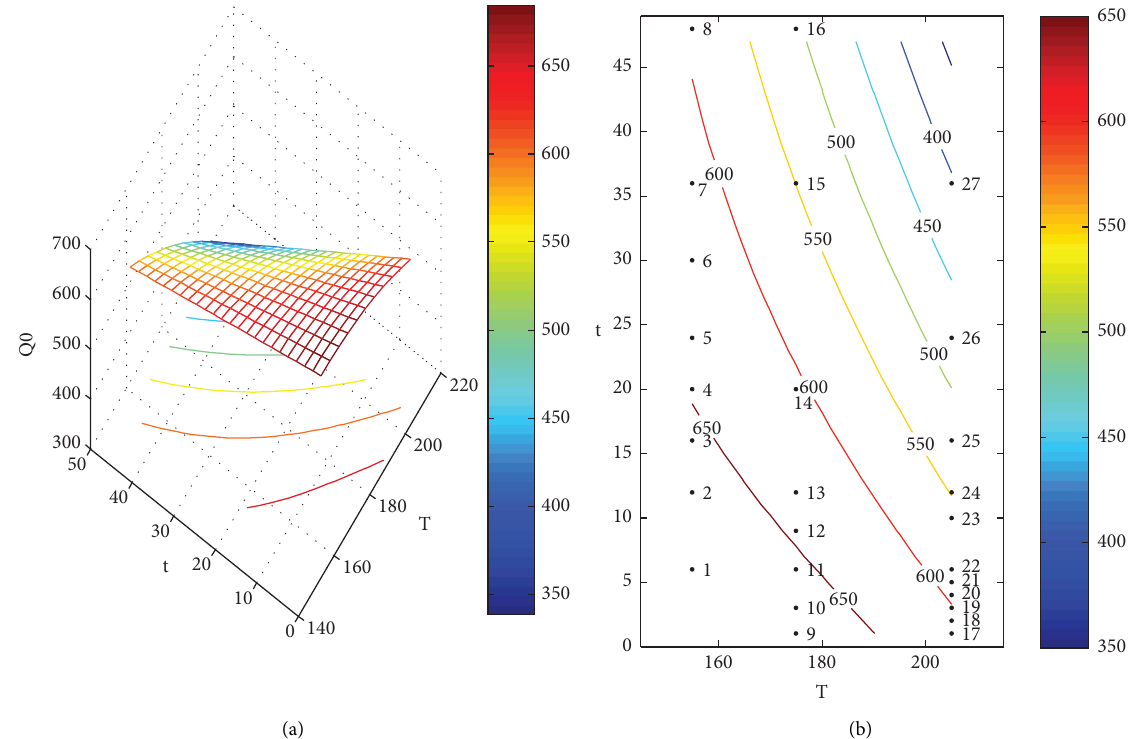
Figure 8: 3D surface graph of the regression model (a) and quality map (b) for Q heat treatment